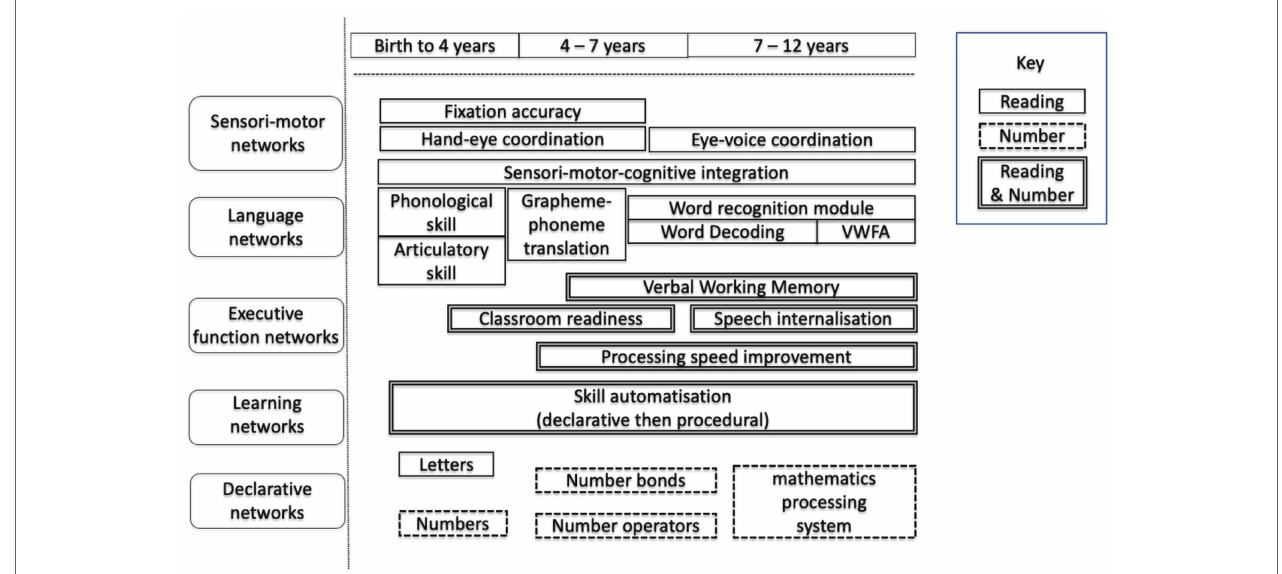
FIGURE 1 | The development of reading skill and mathematics